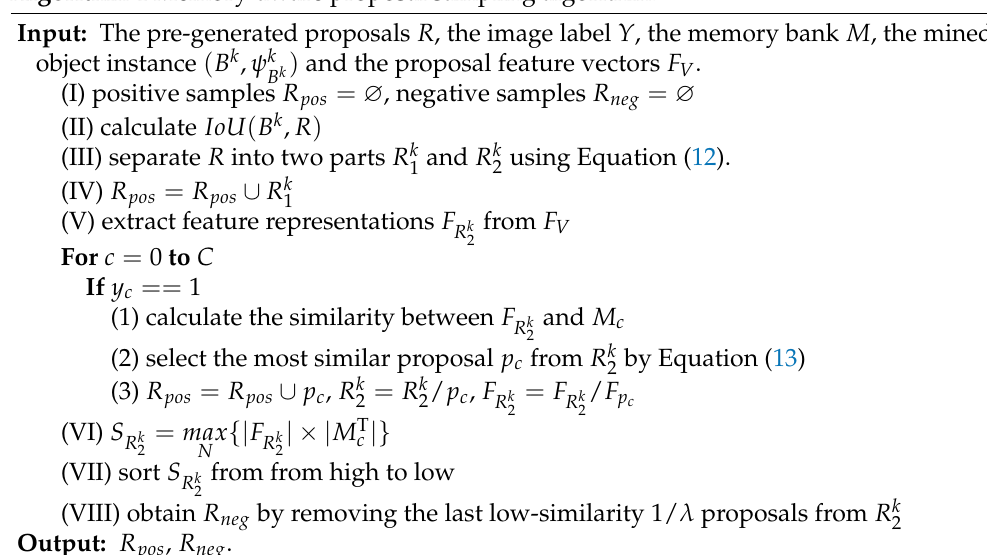
Algorithm 4 Memory-aware proposal sampling